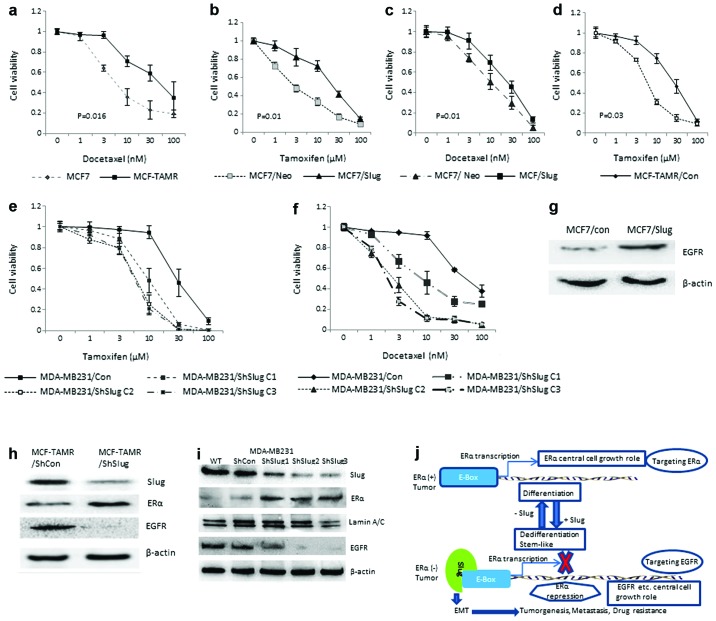
Slug contributes to a drug resistance mediated cell survival pathway between ERα and EGFR. (a) The comparison of sensitivity to docetaxel between MCF7 and MCF-TAMR cells. (b and c) The sensitivity to tamoxifen and docetaxel inhibition of MCF7/Neo and MF7/Slug cells. (d) The comparison of sensitivity to tamoxifen between MCF7-TAMR/ShCon and MCF-TAMR/ShSlug. (e and f) The sensitivity to tamoxifen and docetaxel between MDA-MB-231/ShCon and various MDA-MB-231/ShSlug clones. The docetaxel treatments were performed for 48 h. The cell number was counted after 48-h recovery time. The tamoxifen treatments were performed for 5 days. The cell number was counted after 48-h recovery time (error bars indicate SD, n=3 independent experiments). (g) The expression level of EGFR and β-actin in MCF7/Con and MCF7/Slug. Cell protein extracts (50 μg) were loaded in each lane, and the membranes were probed with anti-EGFR, and β-actin antibodies, respectively, to detect the protein. (h) The expression level of Slug, ERα, EGFR, and β-actin in MCF-TAMR/ShCon and MCF-TAMR/ShSlug. Cell protein extracts (50 μg) were loaded in each lane, and the membranes were probed with anti-Slug, ERα, EGFR and β-actin antibodies to detect the protein. (i) The expression level of Slug, ERα, EGFR, Laminin A/C and β-actin in MDA-MB-231/ShCon and MBA-MB231/ShSlug clone 1, 2 and 3. Cell cytoplasm or nuclear protein extracts (50 μg) were loaded in each lane and the membranes were probed with anti-Slug, ERα, EGFR, Laminin A/C and β-actin antibodies to detect the protein. (j) A model showing possible mechanisms for the alteration of cell characteristics by Slug mediated ERα and EGFR expression.